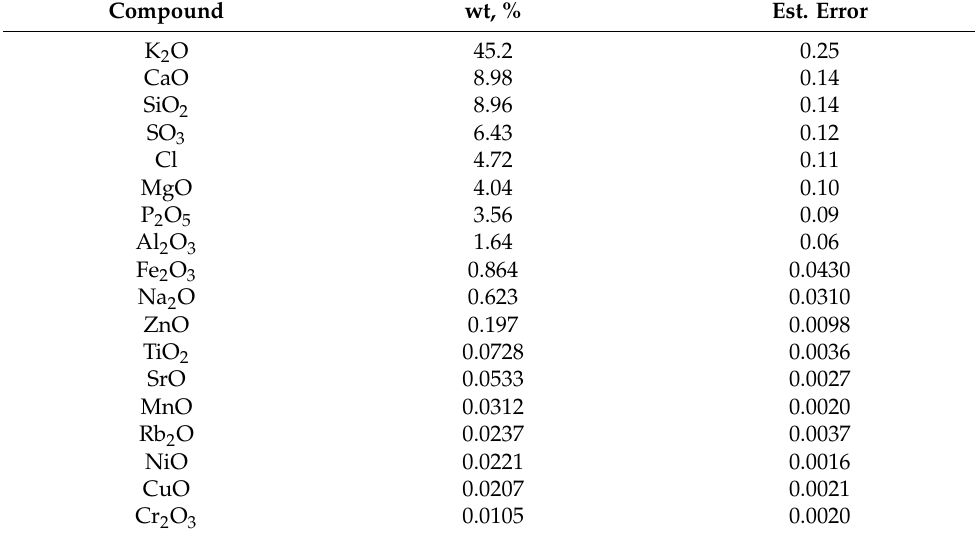
Table 3. X-ray fluorescence of